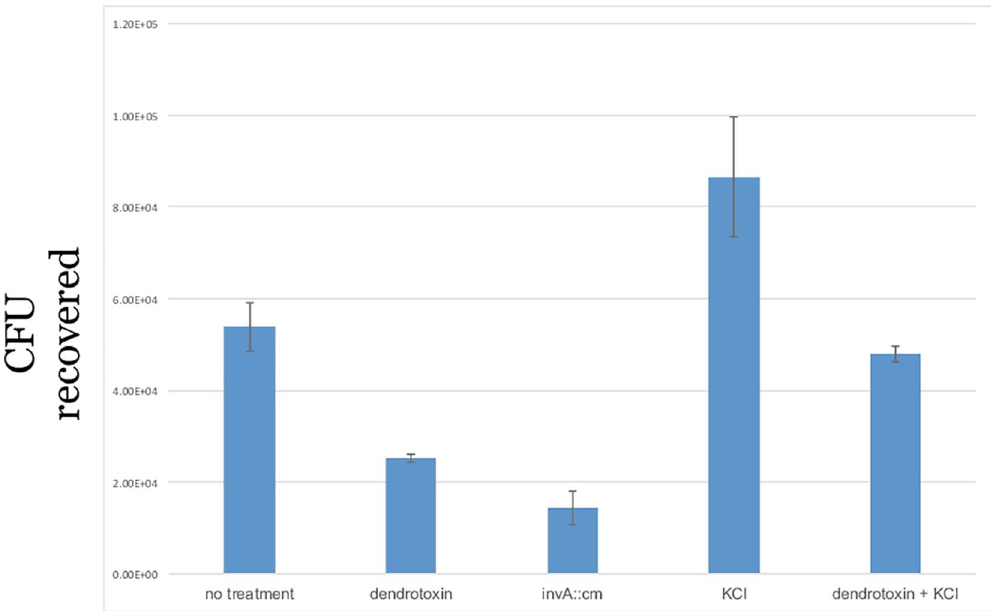
Fig 5. An invasion assay was performed with MCF-7 cells that were untreated or treated with dendrotoxin or treated with dendrotoxin plus potassium or just potassium. An invA :: cm strain is includedas a control. The experiment was performed in duplicateon two independentoccasions. Error bars depict the standarderror of the mean. * p-value <